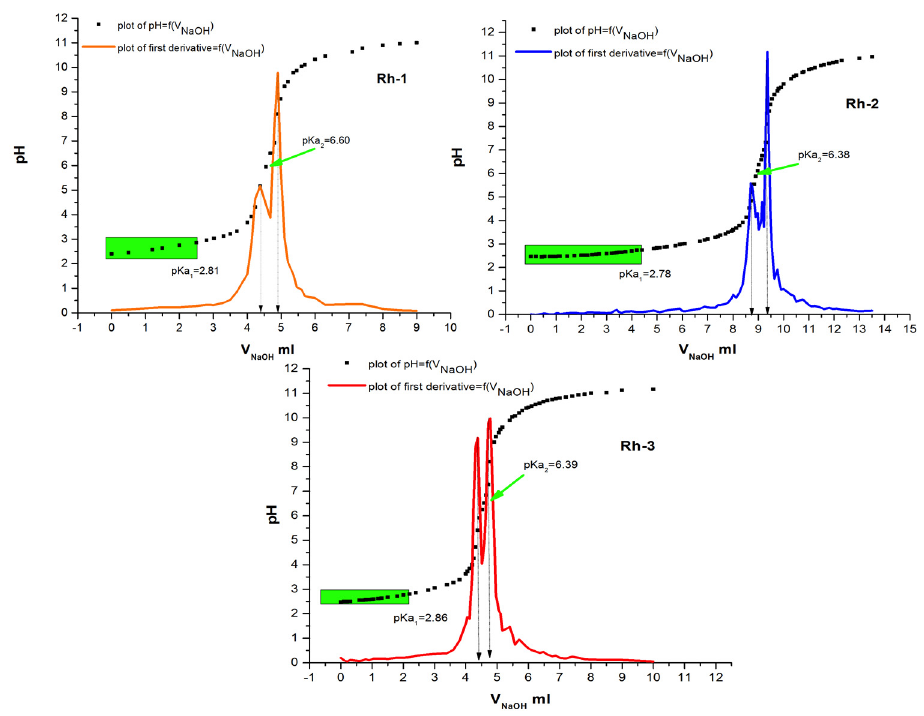
Table 1. Physicochemical characterization of Rh-1, Rh-2, and Rh-3.